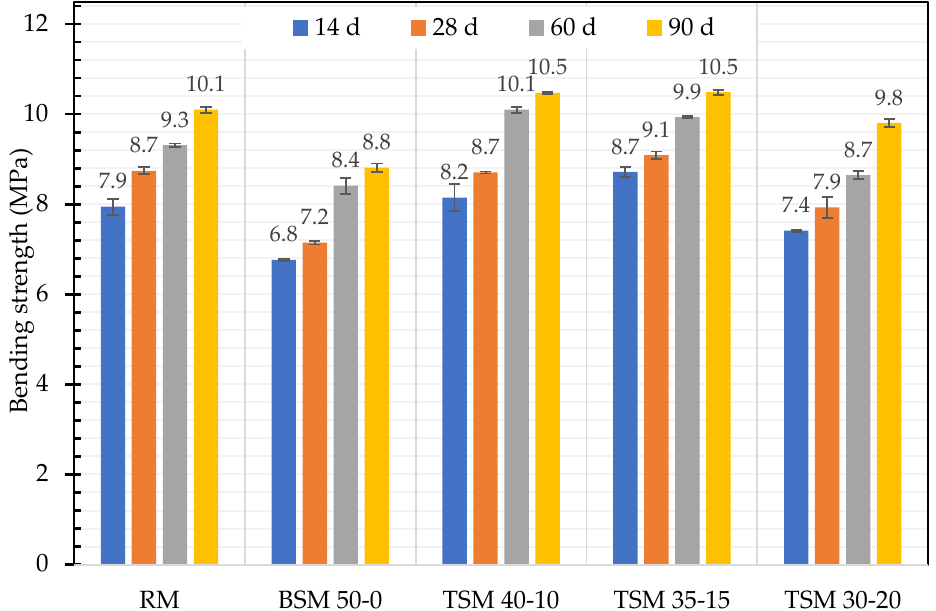
Figure 6. Bending strength of RM, BSM 50-0, TSM 40-10, TSM 35-15, and TSM 30-20 mortars at 14, 28, 60, and 90 days.